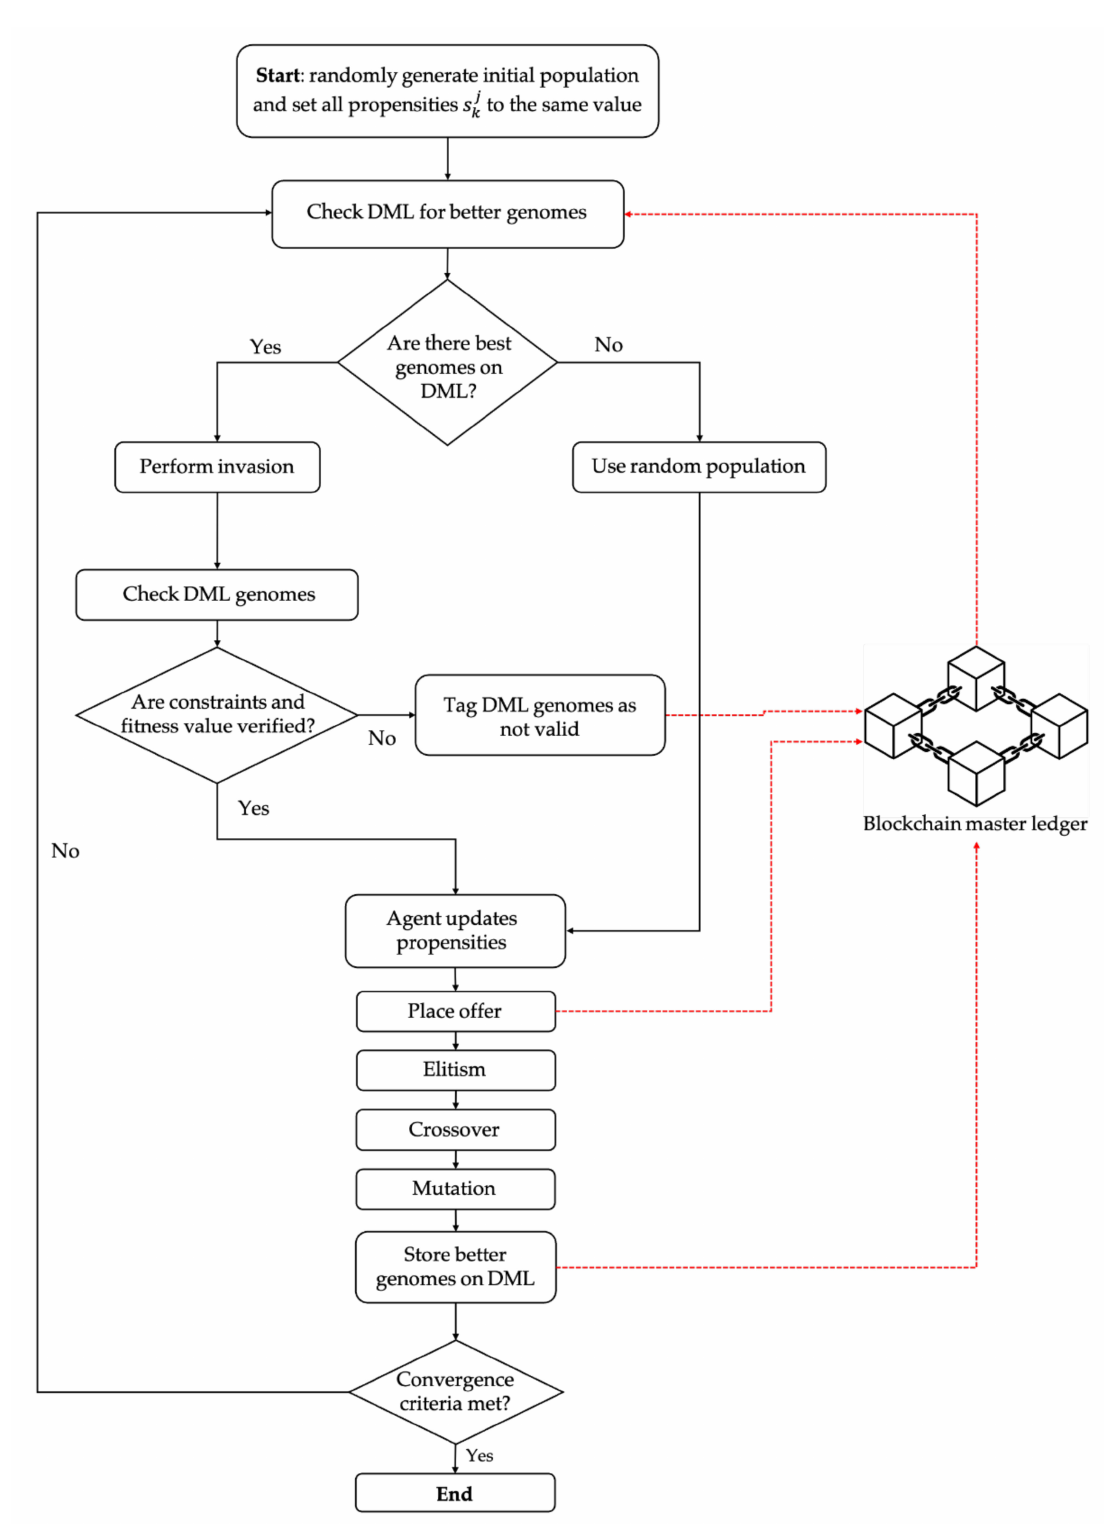
Figure 2. Scheme of the decentralized